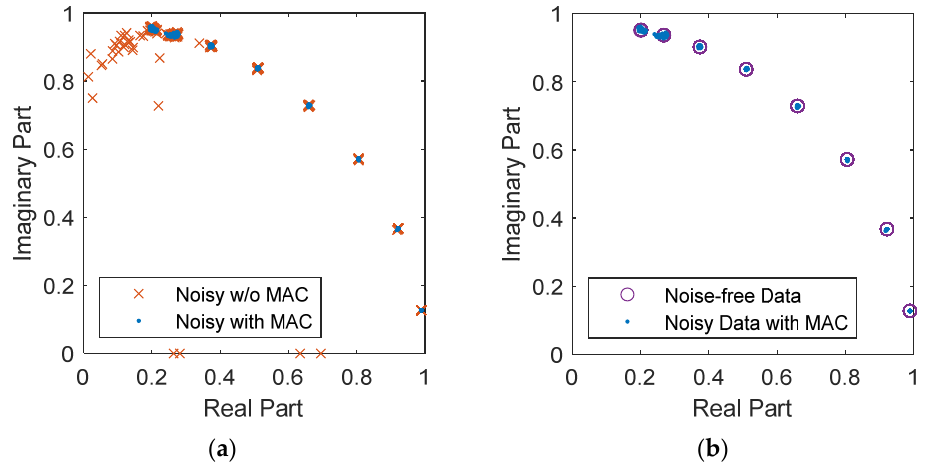
Figure 6. The identified system poles with and without MAC criterion under high noise level. ( a ) without MAC criterion; ( b ) with MAC criterion.